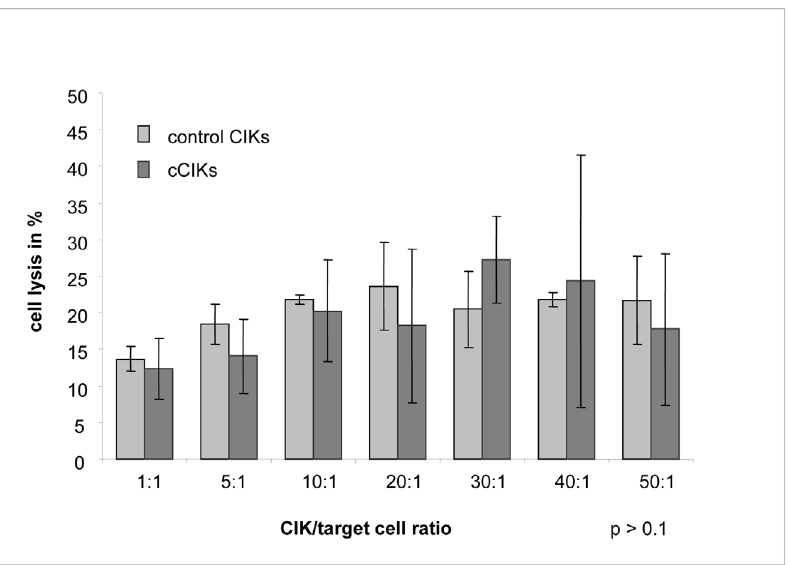
lysis rates increased with increasing effector-cell/target-cell ratio up to a lysis rate of 27% at a ratio of approximately 30:1. Further increases in the ratios did not increase lysis rates further. No significant differences were observed between control CIKs and cCIKs (p . 0.1).